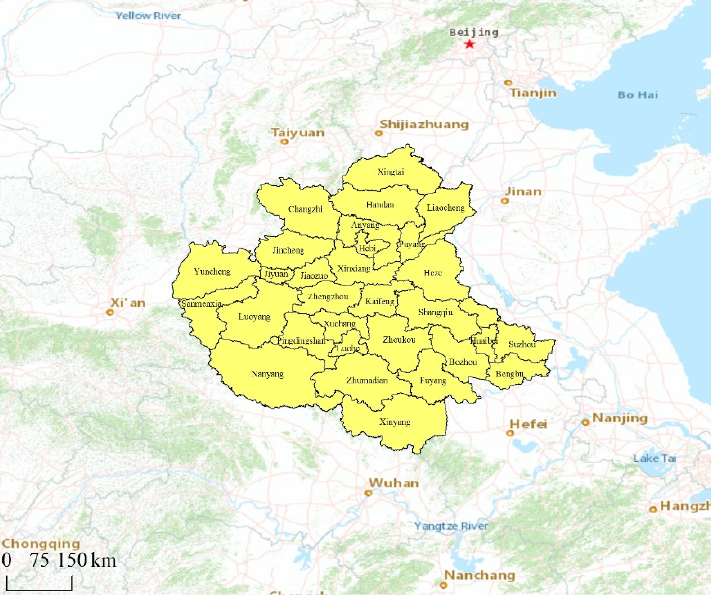
Figure 2. Location of Zhongyuan Urban Agglomeration in China.